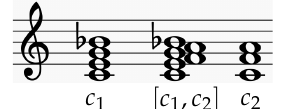
Figure 10. A chord progression c 1 → c 2 with the combined chord [ c 2 , c 1 ]